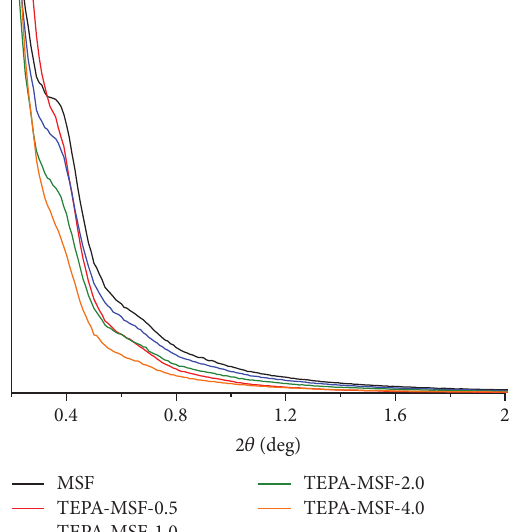
F2:Small-angleXRDpatternsofpureMSFandvariousTEPA- MSF- x samples.